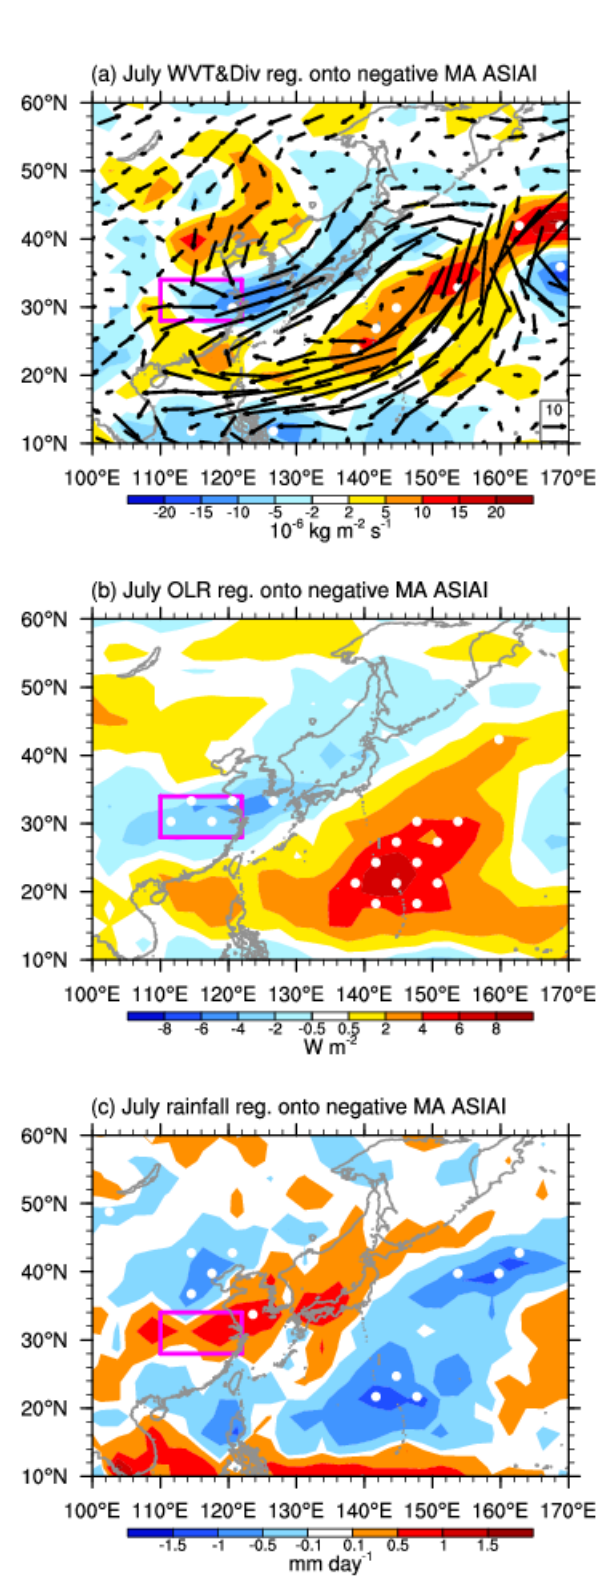
Figure 6. Regressed anomalies of July–mean ( a ) vertically integrated WVT (vectors; unit: kg m − 1 s − 1 ) and WVT_div (shading; unit: 10 − 6 kg m − 2 s − 1 ); ( b ) OLR (shading; unit: W m − 2 ); and ( c ) precipitation (shading; unit: mm day − 1 ), with respect to the normalized negative MA–mean ASIAI.